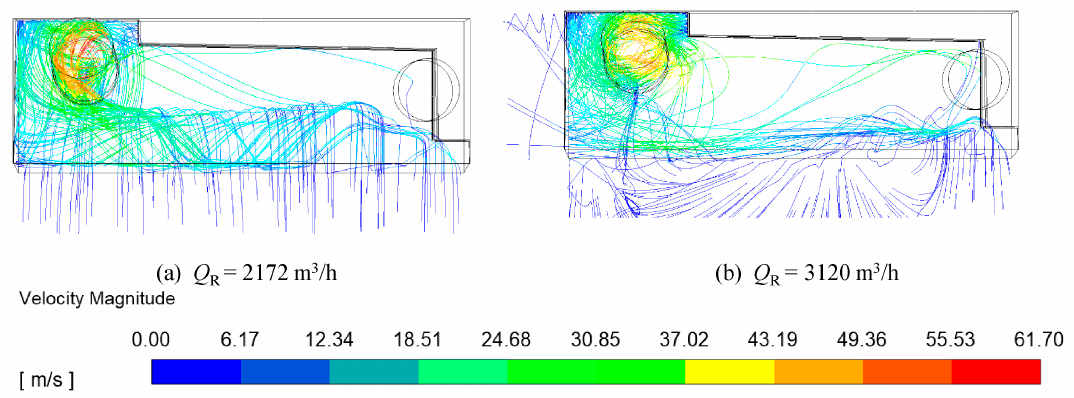
Figure 6. Particle velocity and trajectory of under different reverse-blowing flow rates: ( a ) reverse- Figure 6. Particlevelocityandtrajectoryofunderdifferentreverse-blowingflowrates: ( a )reverse-blowing blowing flow rate is 2172 m 3 /h; ( b ) reverse-blowing flow rate is 3120 m 3 /h. flow rate is 2172 m 3 / h; ( b ) reverse-blowing flow rate is 3120 m 3 /